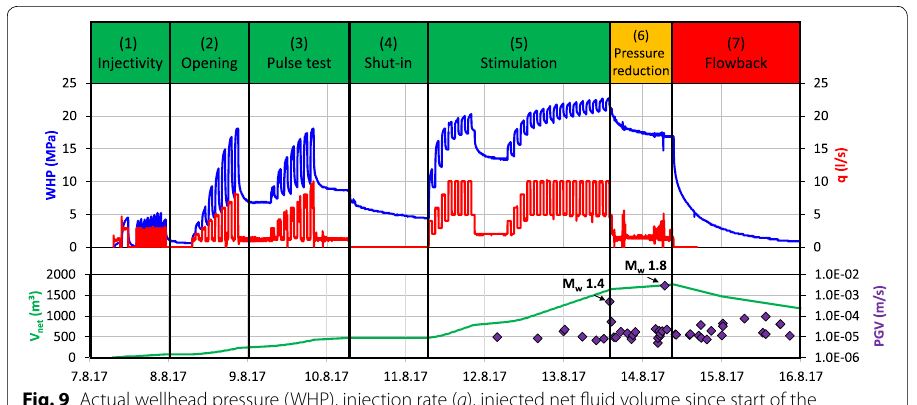
Fig. 9 Actual wellhead pressure (WHP), injection rate ( q ), injected net fluid volume since start of the treatment ( V net ) and peak ground velocity (PGV) of seismic monitoring station MSS01 during the first CSS treatment of well PX‑1 of the Pohang EGS site in Korea in August 2017. The injection sequence is